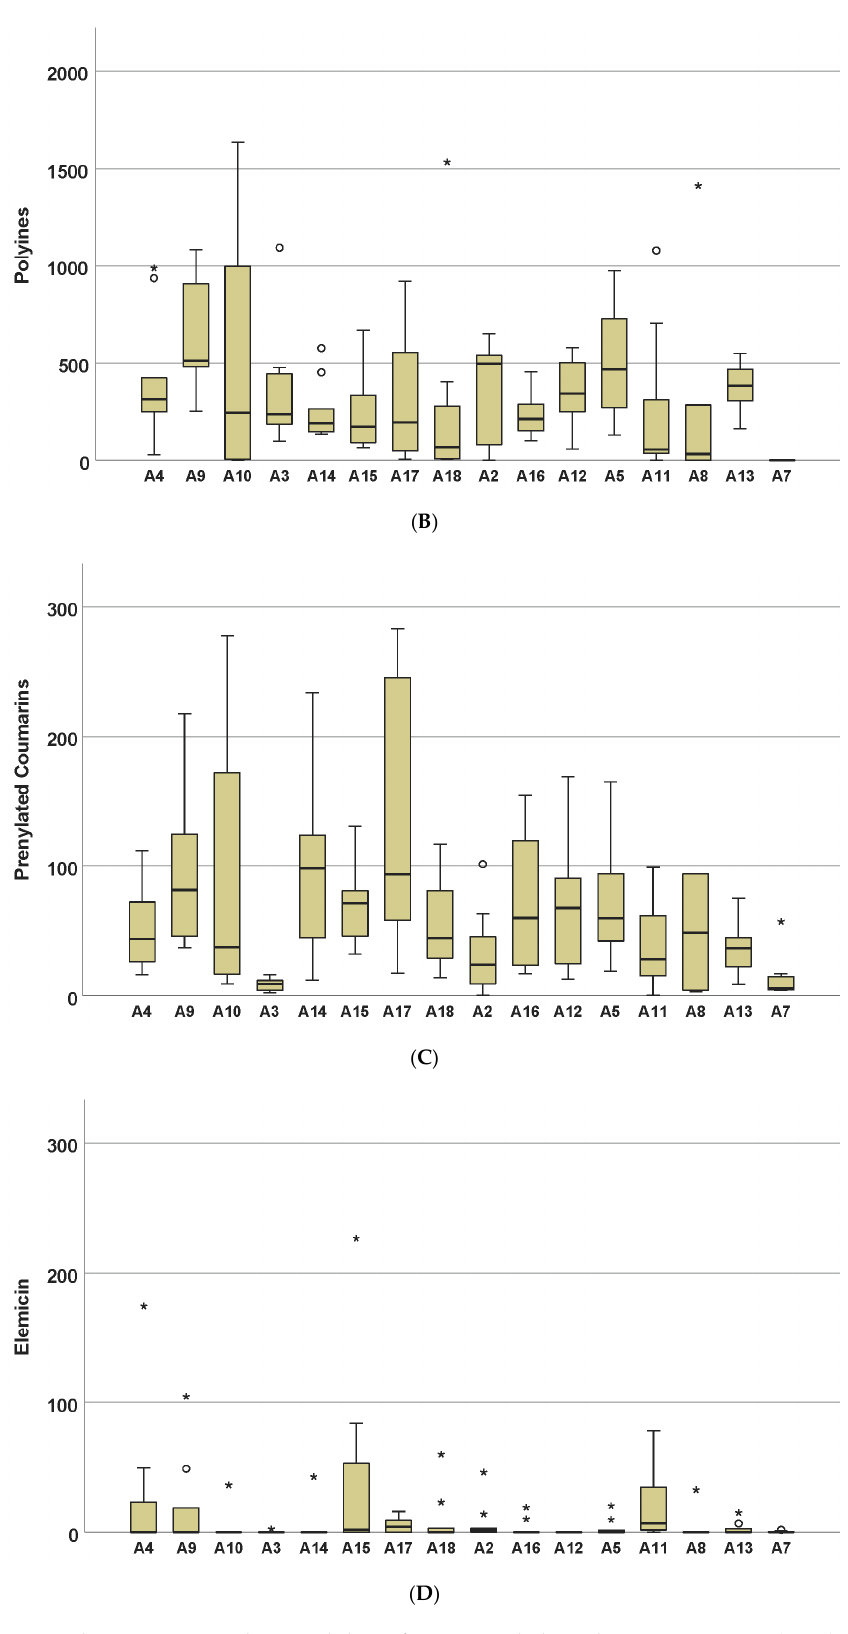
Figure 2. Boxplots presenting the variability of compound classed in 16 accessions ( µ g / g). * and o mark outliers. Order of accessions according to hierarchical cluster analysis (HCA) analysis in Figure 1. ( A ): furocoumarins; ( B ): polyines; ( C ): prenylated coumarins; ( D ):